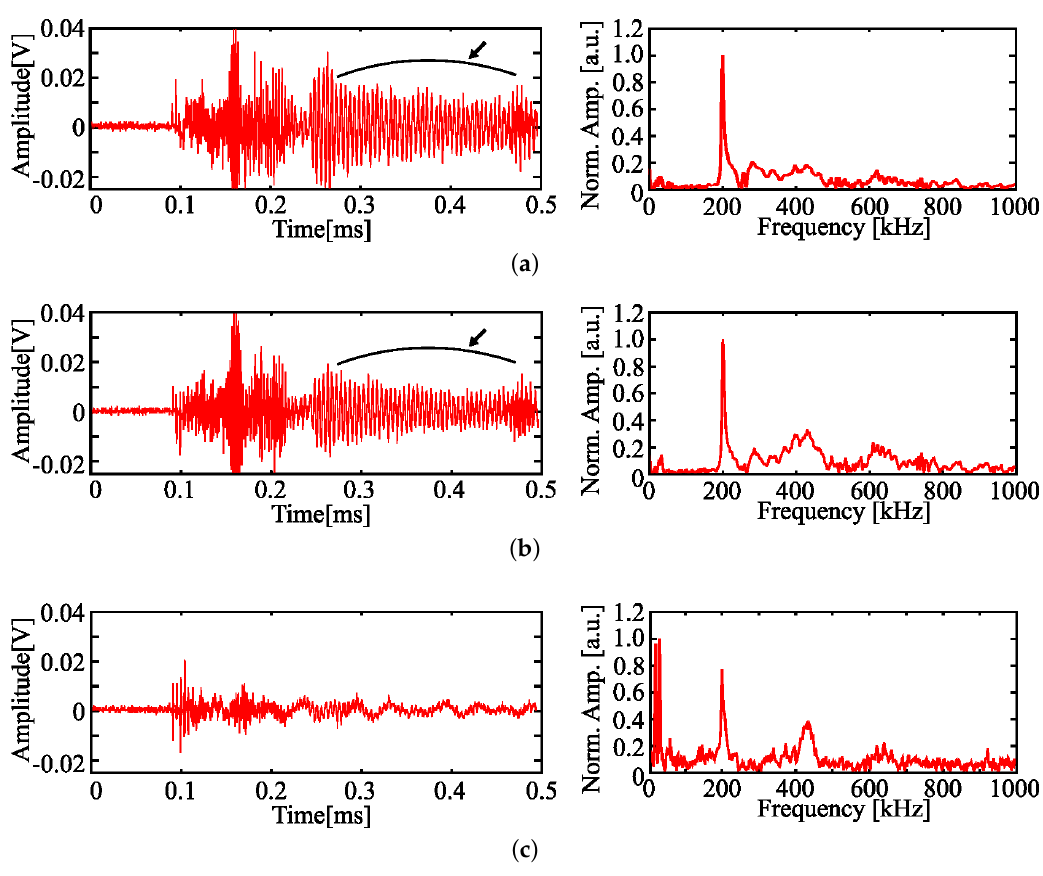
Figure 6. Ultrasonic waveforms and frequency spectrums; ( a – c ) represent the naked steel rod, heated specimen, and intact specimen, respectively.